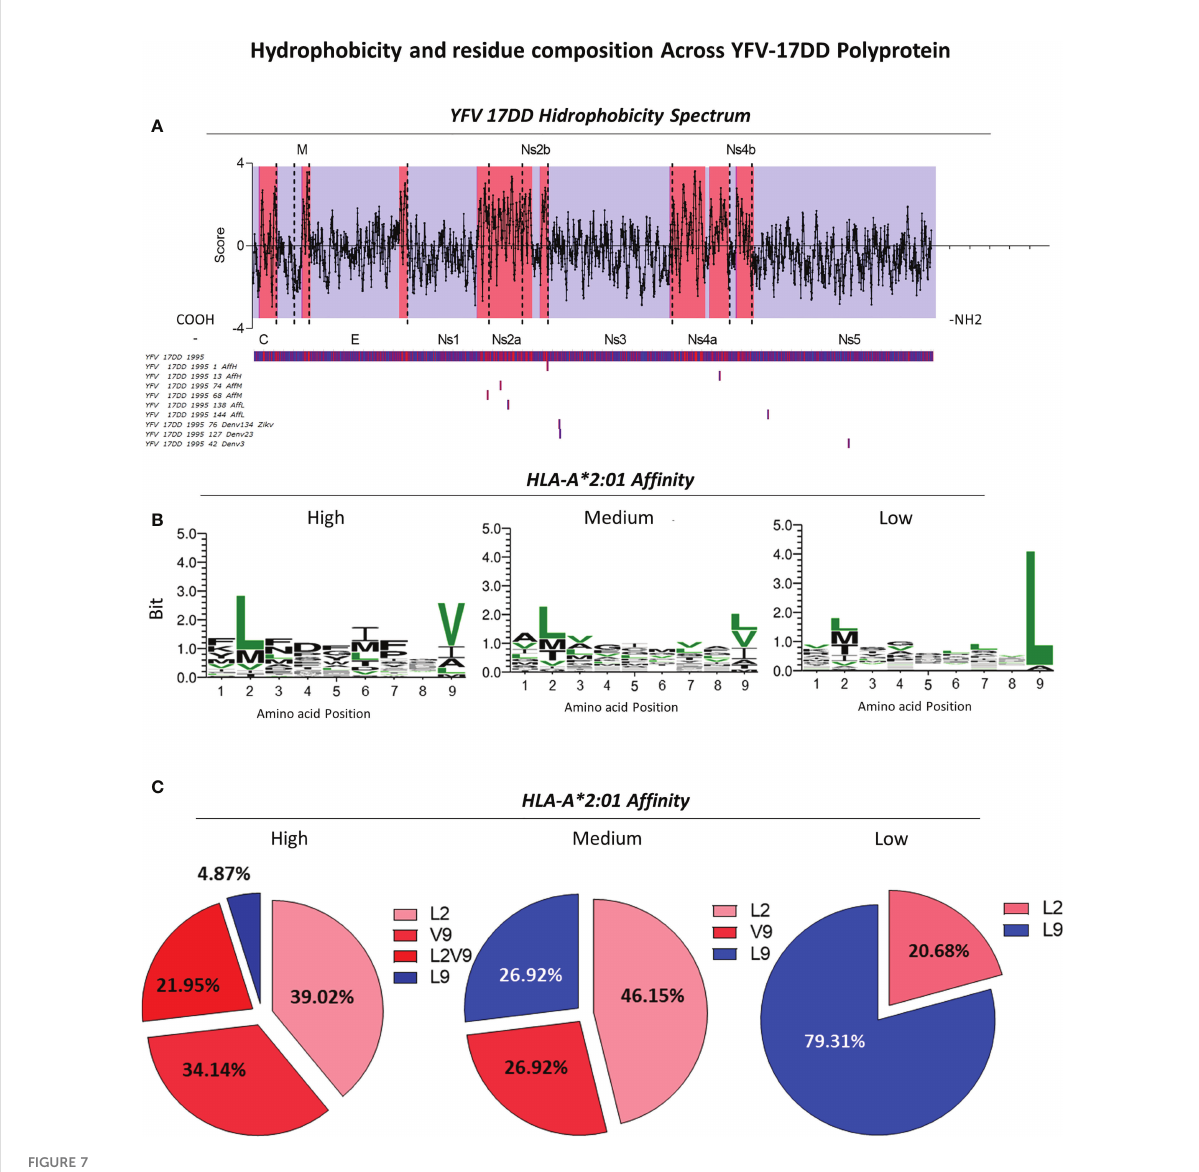
FIGURE 7 Assessment of Hydrophobicity Across YFV-17DD Polyprotein and Conserved Residues in Overlapping Peptides with High, Medium and Low HLA-A*02:01 predicted af fi nity. (A) Hydrophobicity values for YFV-17DD complete polyprotein. Regions of high hydrophobicity are indicated in red and of low hydrophobicity are indicated in blue. The three peptides with complete YFV-17DD overlapping as well as peptides of high, medium and low HLA-A*02:01 af fi nity score were aligned with the YFV-177 polyprotein using MUSCLE algorithm. (B) Logo sequence analysis using two representative peptides of each arbovirus in each HLA-A2 af fi nity range (high, medium and low HLA-A2 af fi nity score). Conserved motifs are indicated in (green). (C) Frequency of leucine and valine in positions 2 and/or 9 for all three HLA-A2 af fi nity